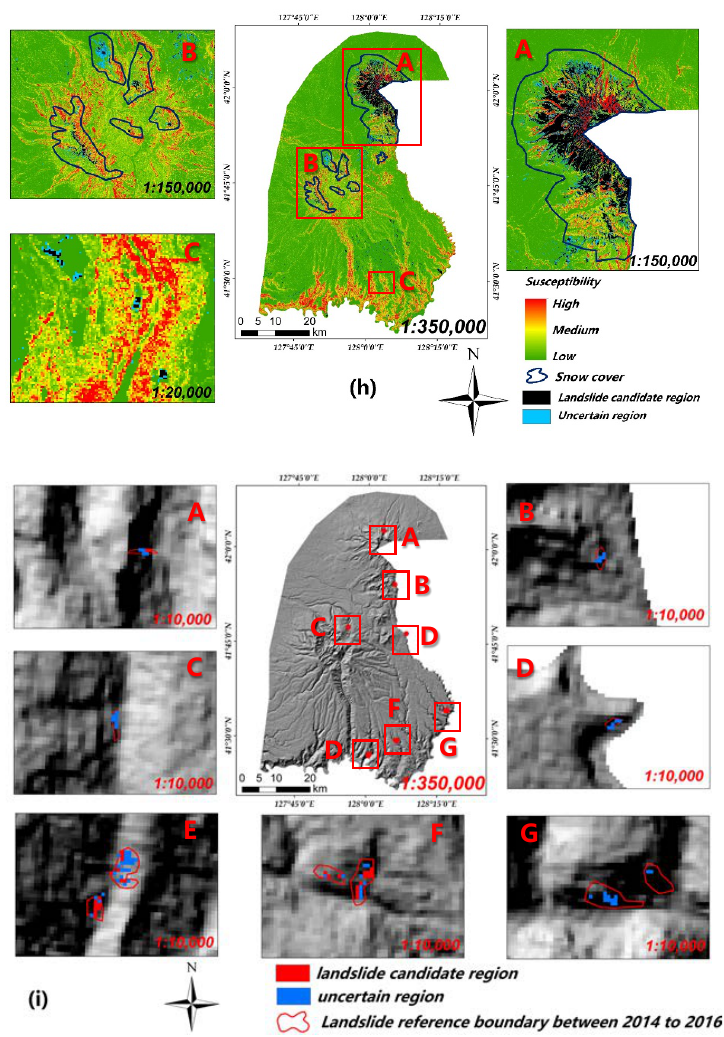
Figure 7. Landslide identification results for the whole study area. ( a ) Pre-event image; ( b ) post-event image; ( c ) reference map; ( d ) difference image; ( e ) thresholding result; ( f ) snow cover; ( g ) susceptibility result; ( h ) overlapping results; ( i ) susceptibility-based change detection thresholding (SCDT) identification results.